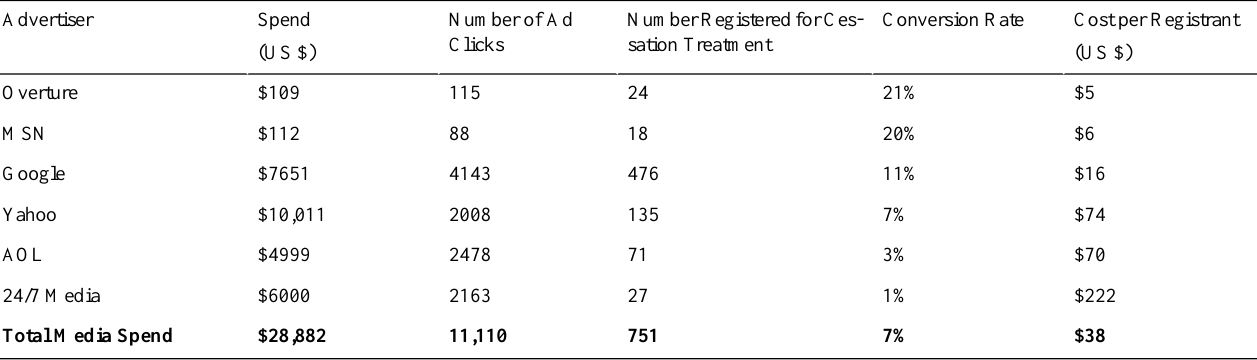
Table 5. Cost-effectiveness in later New Jersey campaigns (August 2006 to October